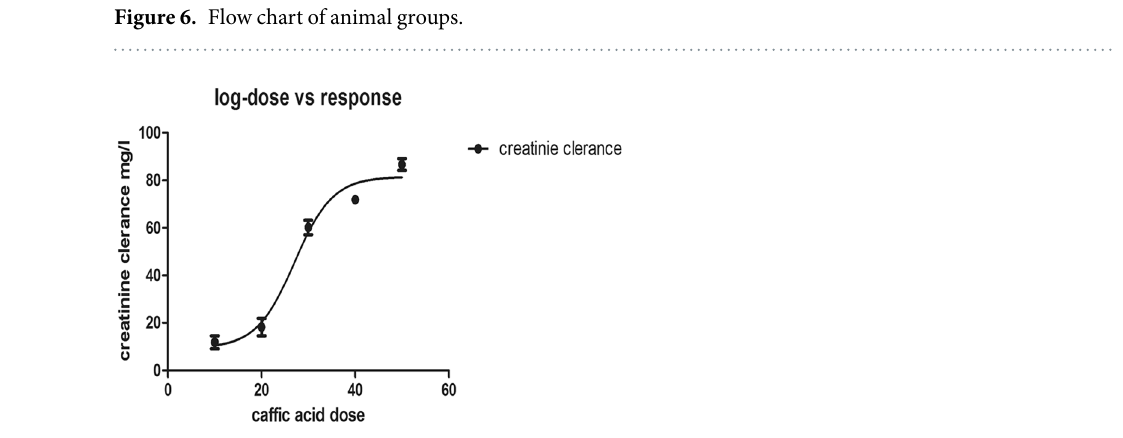
Figure 7. Dose-response effects of Caffeic acid on creatinine clearence level in HFD-STZ-rats. STZ rats were administered Caffeic acid different doses range from (10–50 mg/kg). Creatinine clearence was determined after 4 weeks of caffeic acid treatment. The data are expressed as the means ±